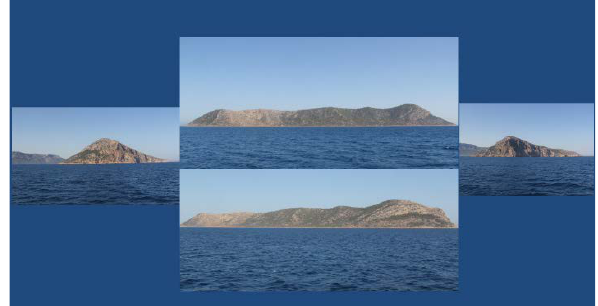
Figure 7. Photographing the island from different angles Mathematical and technical principles remained the same,